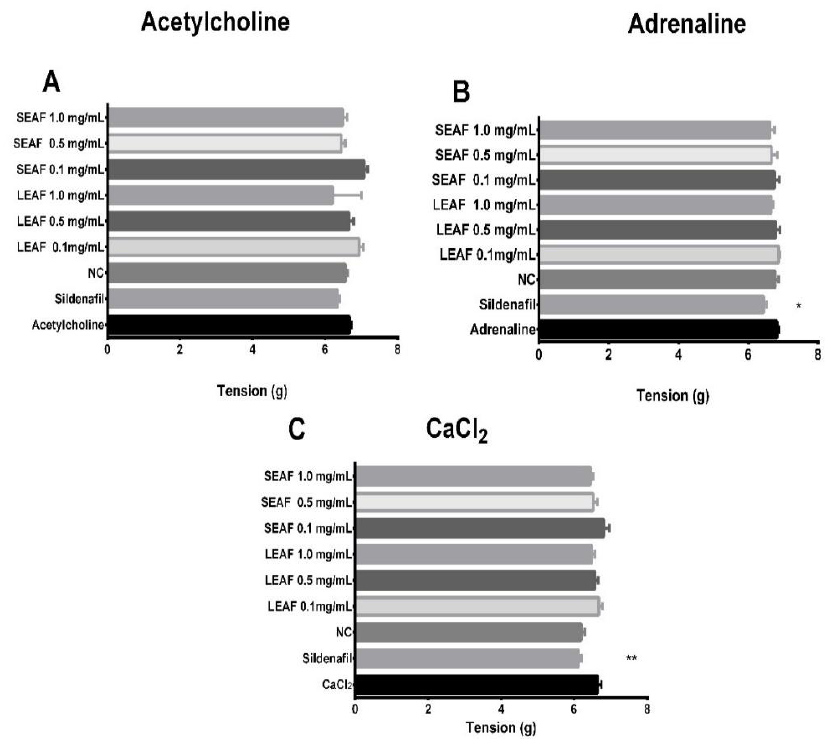
Figure 5. Vasodilator effect in rats treated with J. macrantha and sildenafil. NC: negative control, PC: positive control; LEAF-25: Leaves ethyl acetate fraction 25 mg/kg; LEAF-50: Leaves ethyl acetate fraction 50 mg/kg; LEAF-100: Leaves ethyl acetate fraction 100 mg/kg; SEAF-25: stems ethyl acetate fraction 25 mg/kg; SEAF-50: stems ethyl acetate fraction 50 mg/kg; SEAF-100: stems ethyl acetate fraction 100 mg/kg; * p < 0.05 (Dunnet’s Test) compared to adrenaline; ** p < 0.001 (Dunnet’s Test) compared to CaCl 2 ; n.s.: non-significant difference.